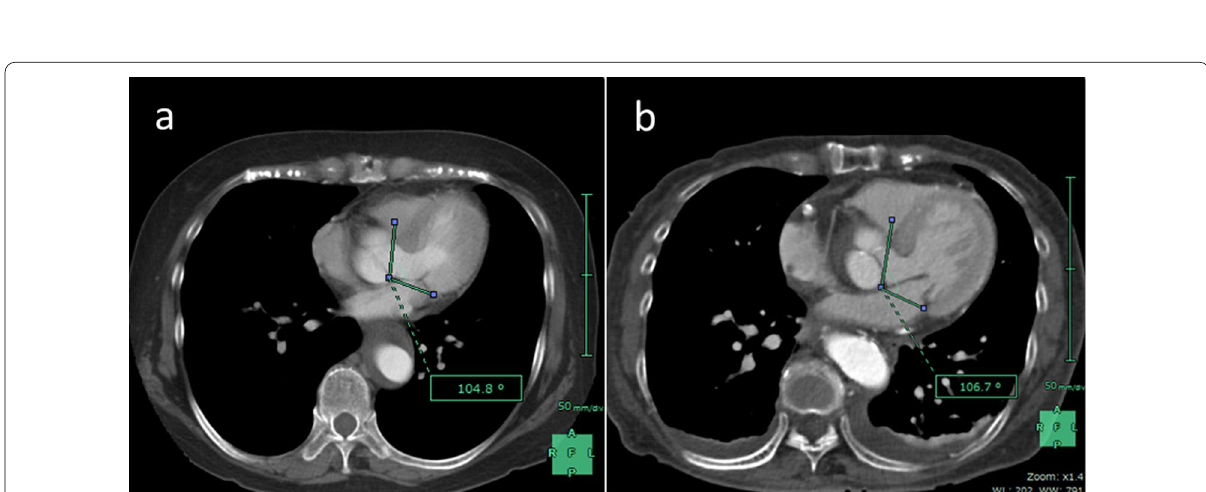
Fig. 5 Narrow aorto-mitral angle detected in computed tomography. a Her past image before the onset of acute type A aortic dissection (at the onset of type B aortic dissection). b Preoperative image after the onset of acute type A aortic dissection. Both images have almost the same